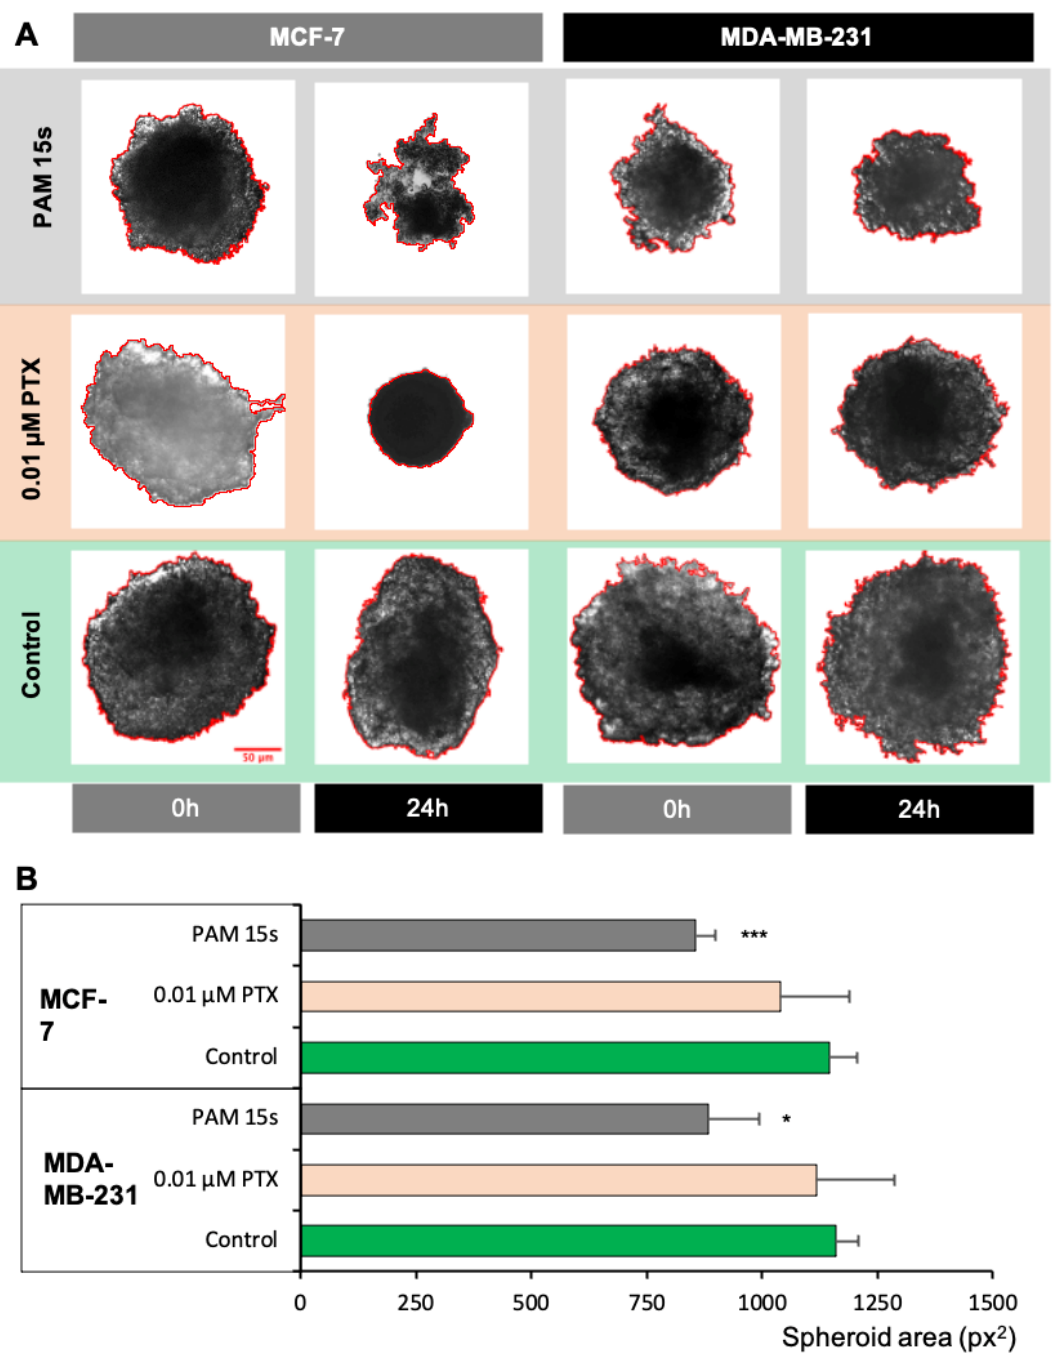
Figure 4. Spheroid area assessment of the MCF-7 and MDA-MB-231 cell culture experimental variants. ( A ) Representative images of the MCF-7 and MDA-MB-231 spheroids obtained by hanging drop method and treated with PTX and PAM 15 s. Column 0 h represents the spheroids before the treatment was added, while column 24 h represents the images of spheroids 24 h after the treatment. The evaluation of shrinkage/growth was assessed by taking photographs of the same spheroid as at the beginning of the treatment. Analysis consisted of the calculation of the area of total spheroid by Fiji software. ( B ) Mean area of spheroids (pixels 2 ) following the treatment with PTX and PAM 15 s were acquired at 24 h after the treatment. Data are mean and SEM values ( n = 8). * p < 0.05; ** p < 0.01; *** p < 0.001 (ANOVA).